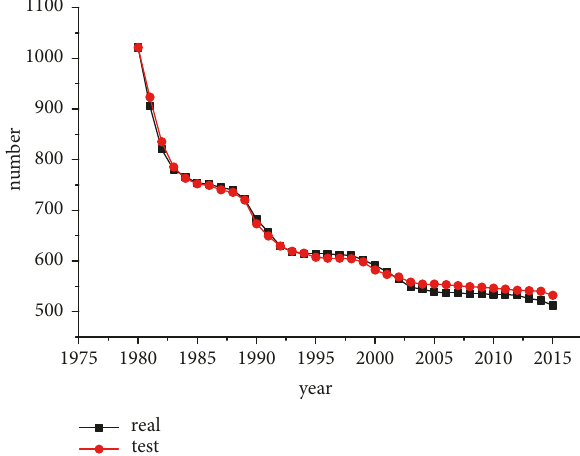
Figure 2: The statistical results comparison of SOLEM propagation (denoted as test) and historical evolution (denoted as